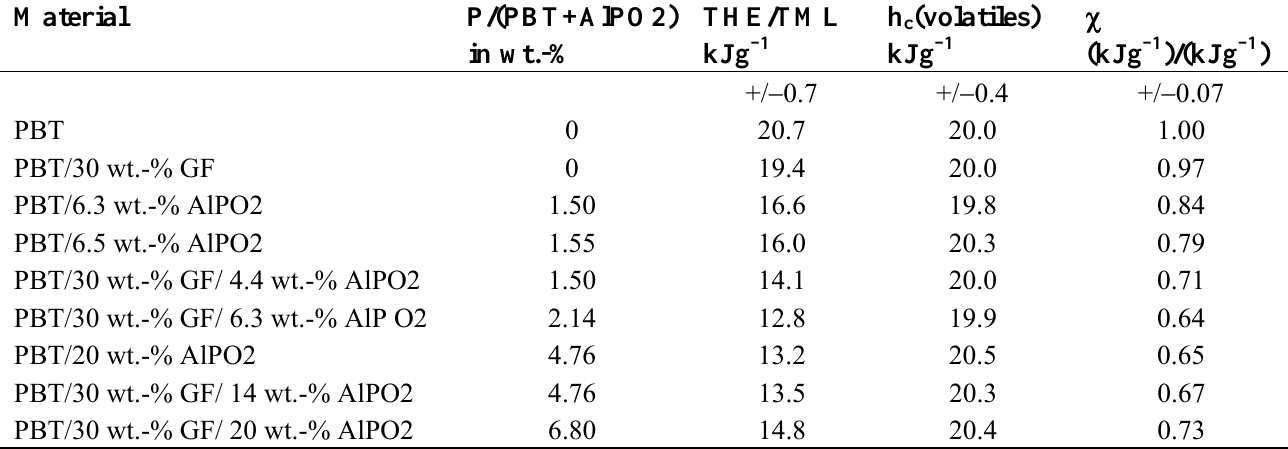
Table 1. Reduction of the combustion efficiency χ in the cone calorimeter (irradiation 50 kWm –2 ) through flame